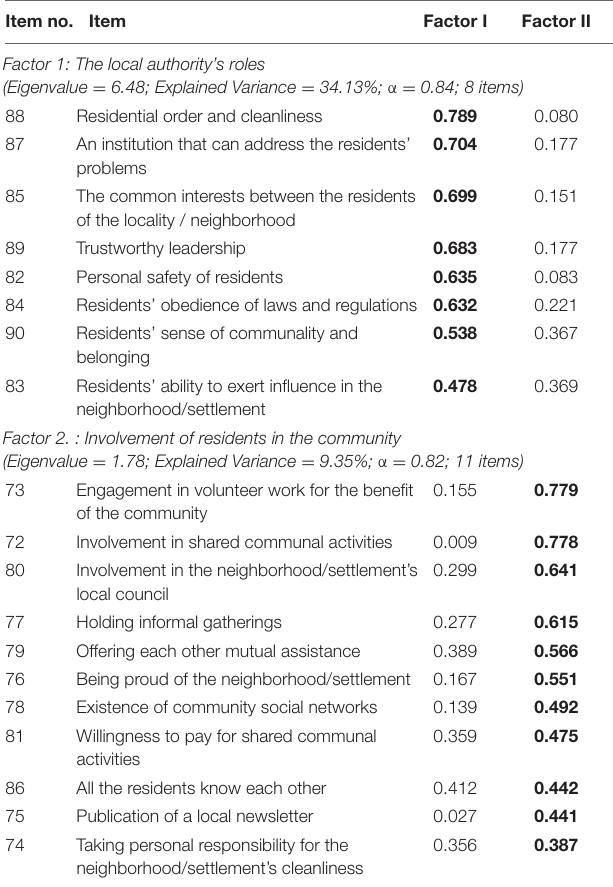
TABLE 1 | The scale of parents’ perception of communality